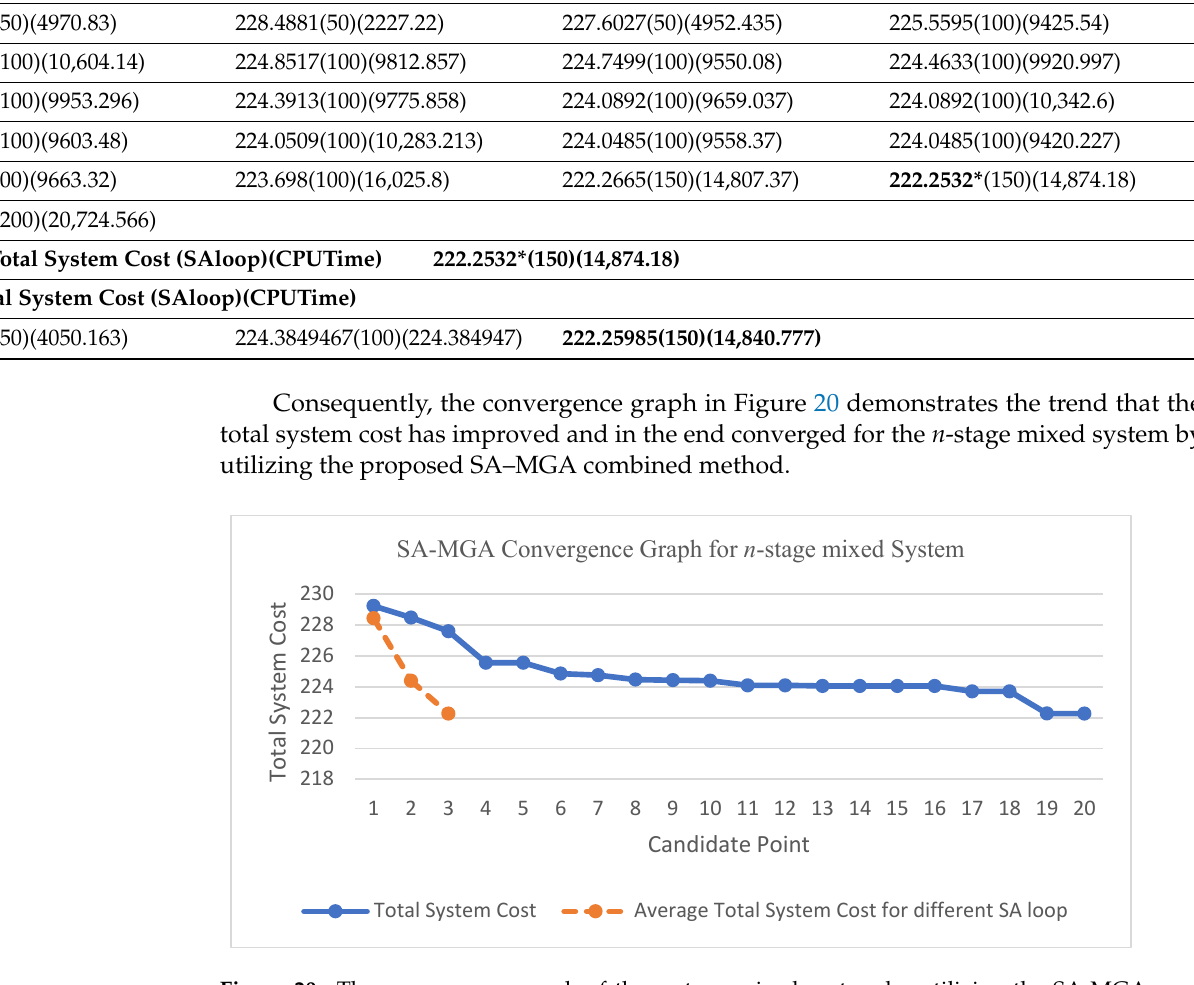
Table 39. The total system costs of 21 simulation runs obtained by SA–MGA for the n -stage mixed system. cr-rate = 0.95 mu-rate = 0.5 GApopulation = 200 GAloop = 200 Total System Cost (SAloop) (CPU Time)